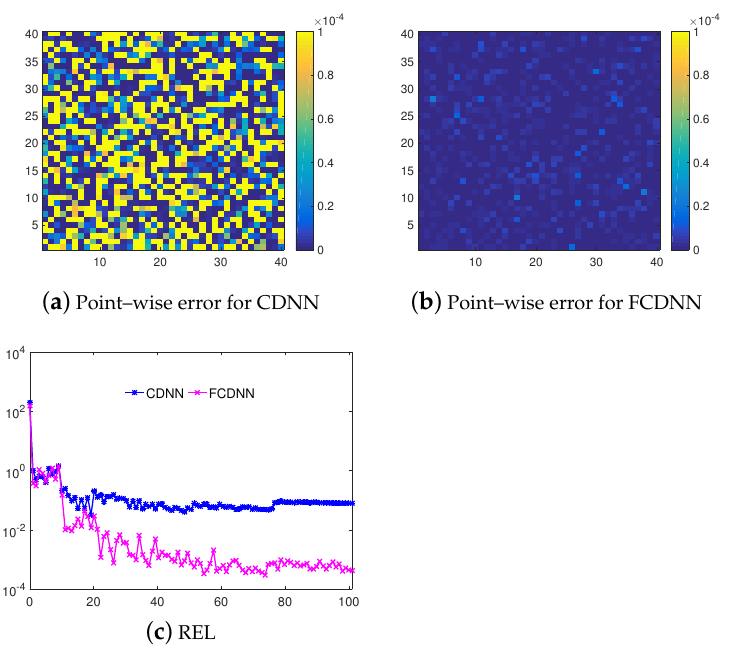
Figure 7. Testing results for Example 4.